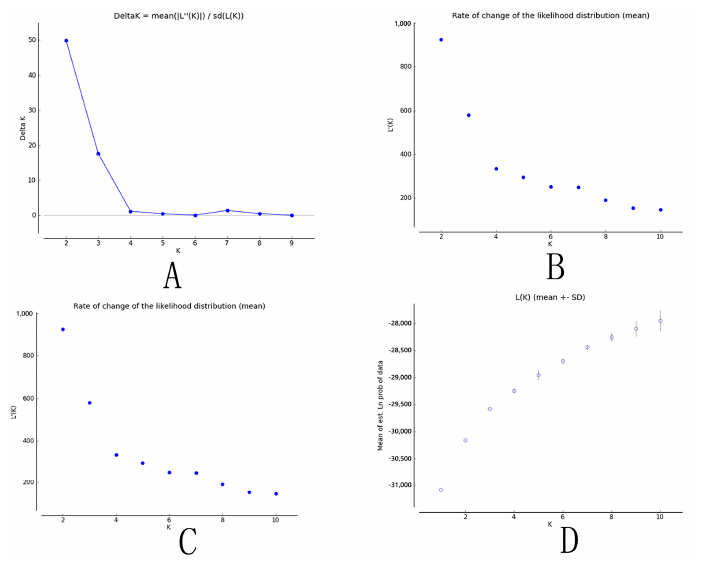
Figure 3. Scatter diagrams of the parameters from the STRUCTURE analysis. A : Δ K; B : L’(K); C : L’’(K); and D : Ln P(D).